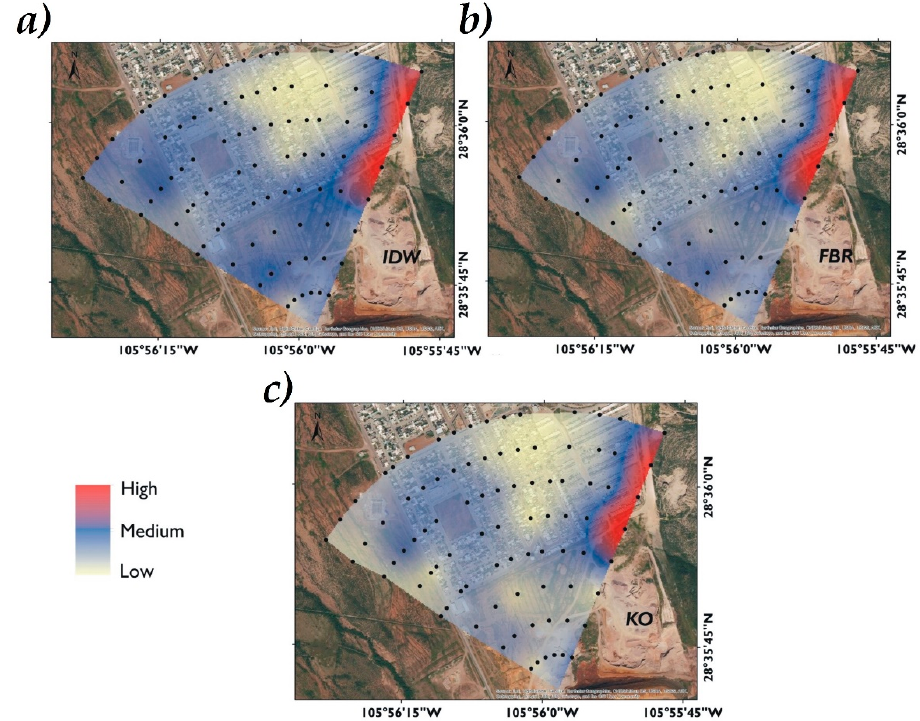
Figure 10. Error maps in P1 between experimental values and those estimated by interpolation models. IDW ( a ), RBF ( b ), and OK ( c ). Samples ( ● ), errors between the experimental values and estimated values: high ( ■ ), medium ( ■ ), low ( ■ ).